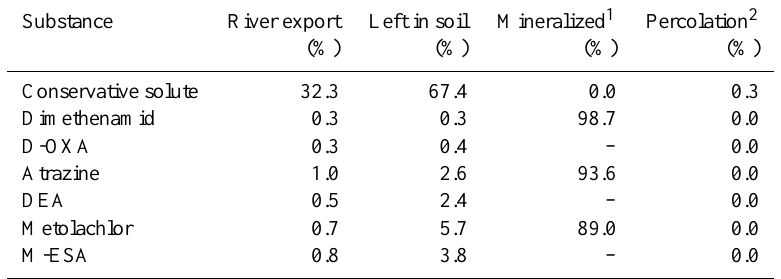
Table 5. Modelled substance balances at the end of the modelling period. The percentage is related to the sum of application mass and initial soil substance.